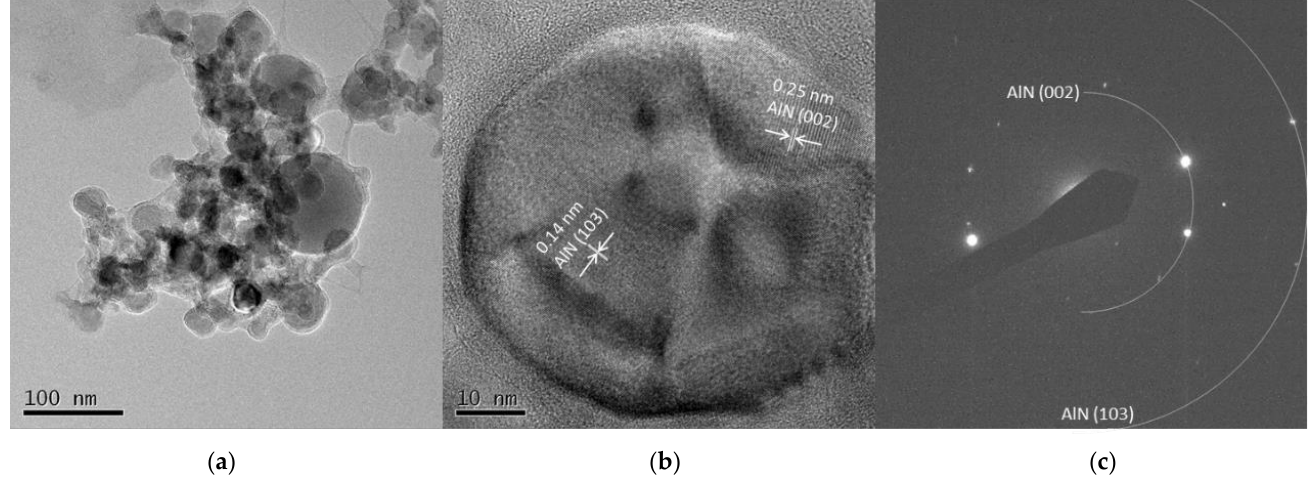
Figure 7. TEM images of Al 5 A particles ( a ) low resolution image; ( b ) high resolution image; ( c ) SAED pattern